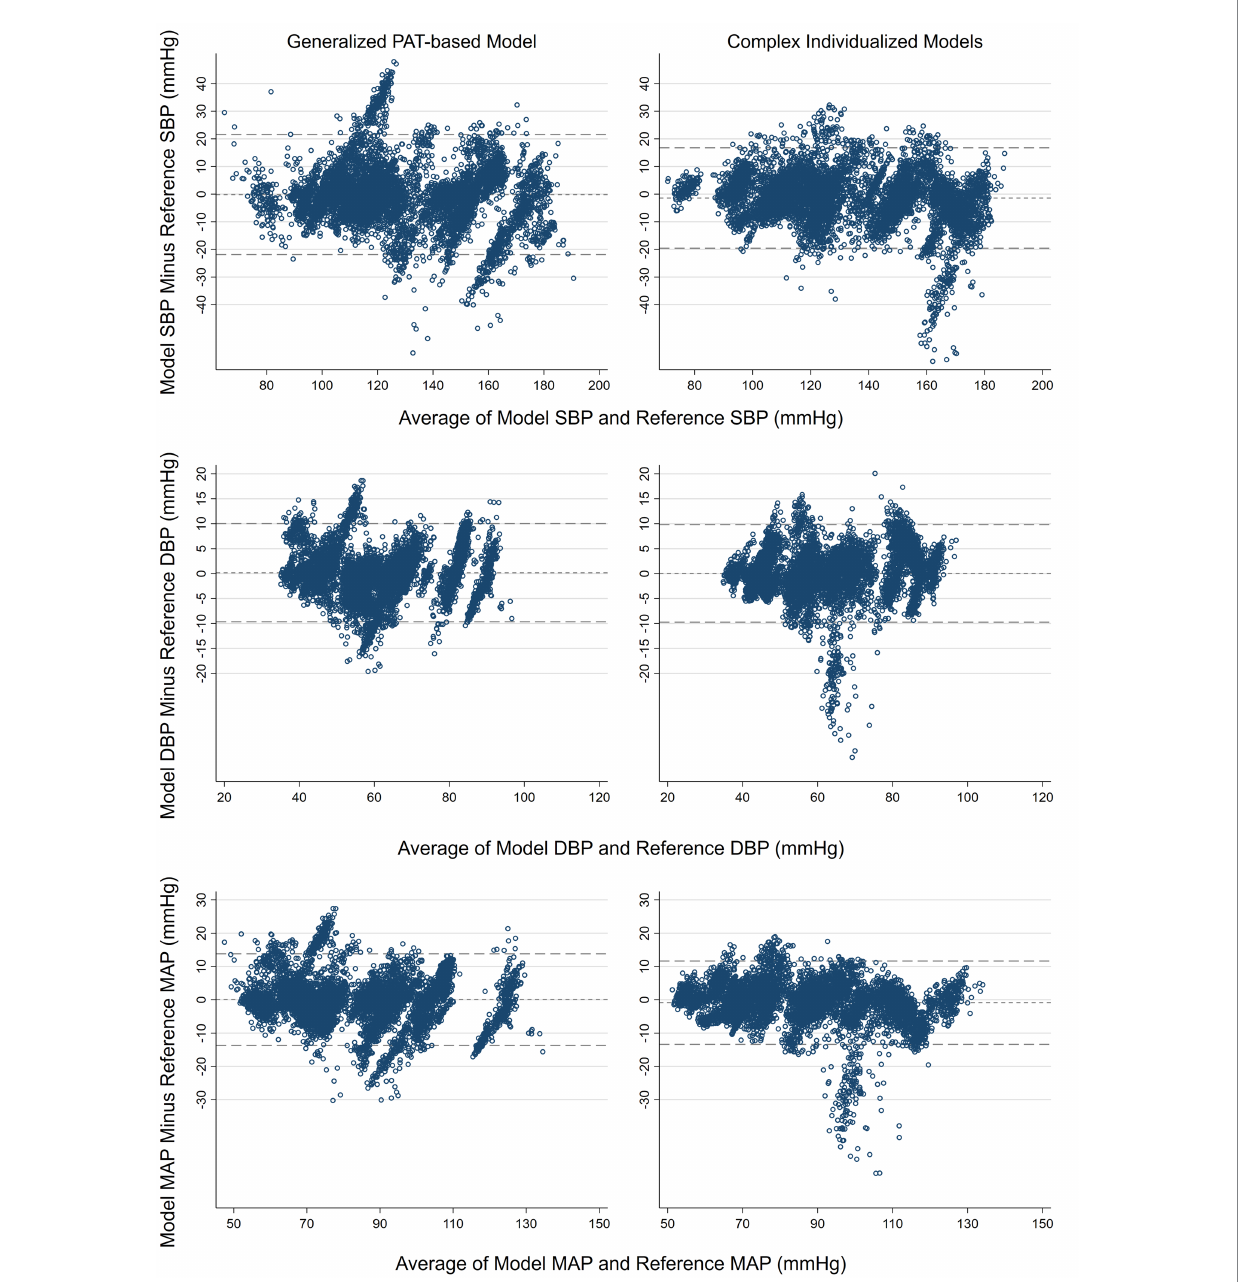
FIGURE 3 Bland–Altman plots. Mean of reference and model ( x -axis) plotted against the difference between reference and model ( y -axis). Horizontal lines indicate bias and upper and lower 95% limits of agreement. SBP, systolic blood pressure. DBP, diastolic blood pressure. MAP, mean arterial